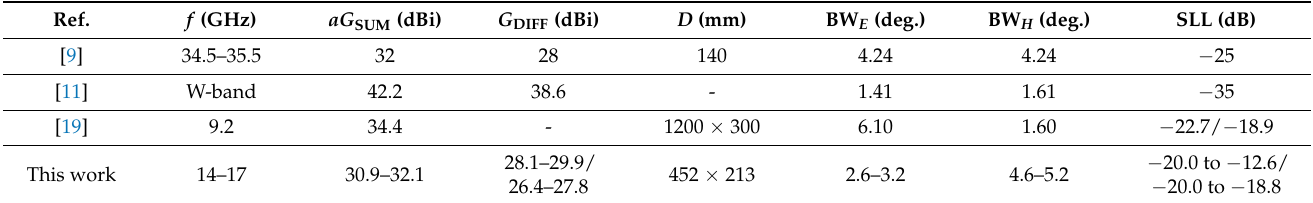
Table 3. Comparative Analysis.